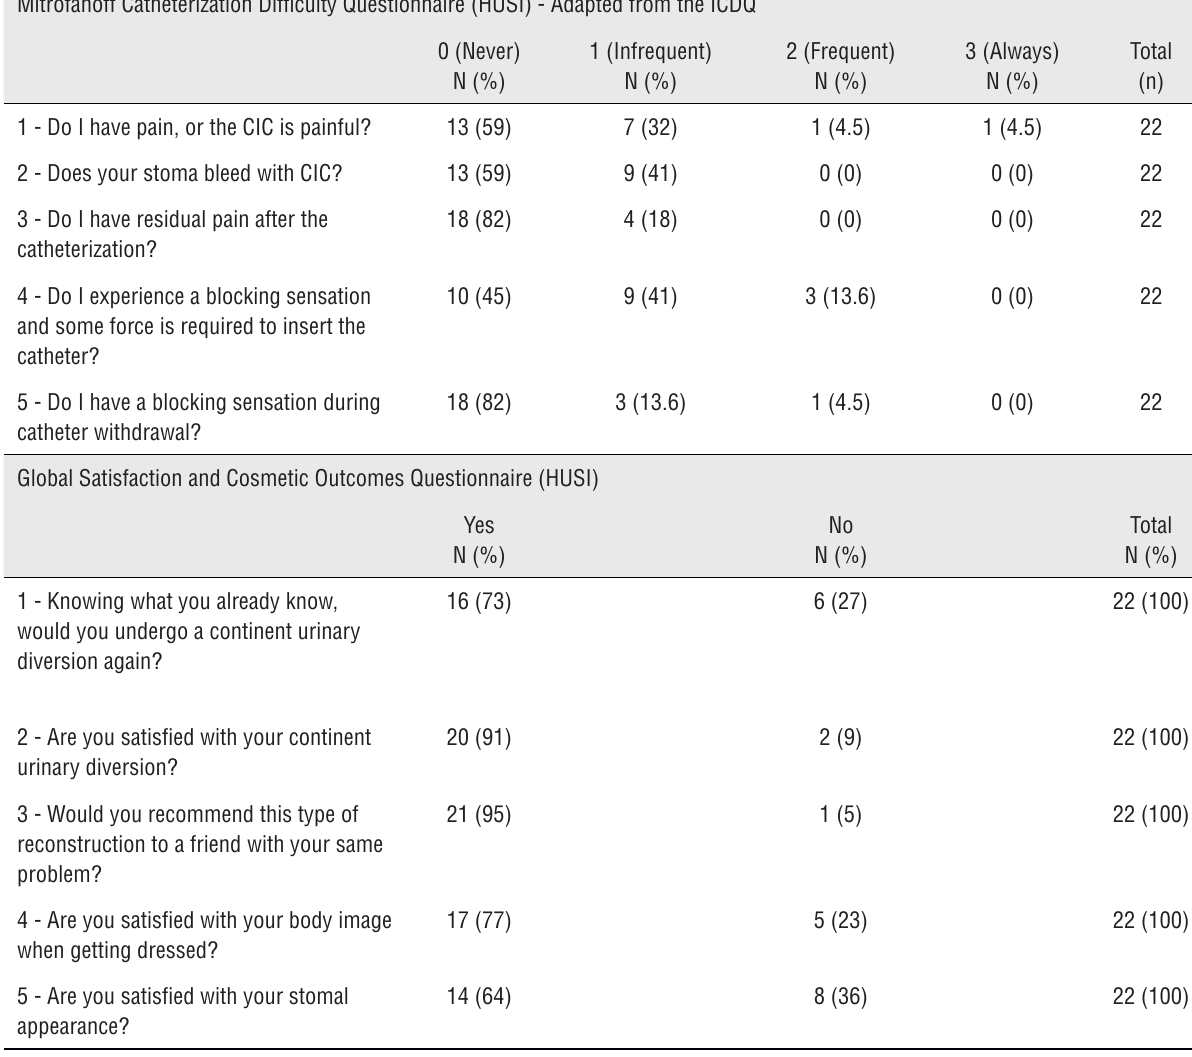
Table 2 - Mitrofanoff Catheterization Difficulty Questionnaire (HUSI) - Adapted from the ICDQ and Global Satisfaction and Cosmetic Outcomes Questionnaire